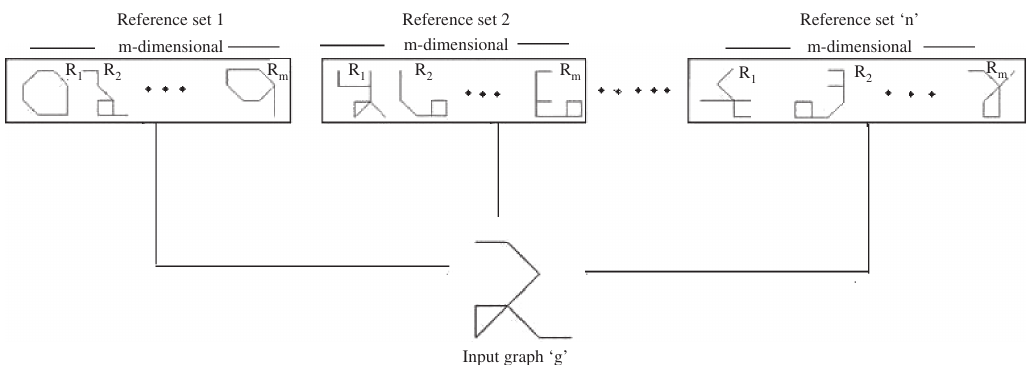
Figure 8: Illustration of the Compared